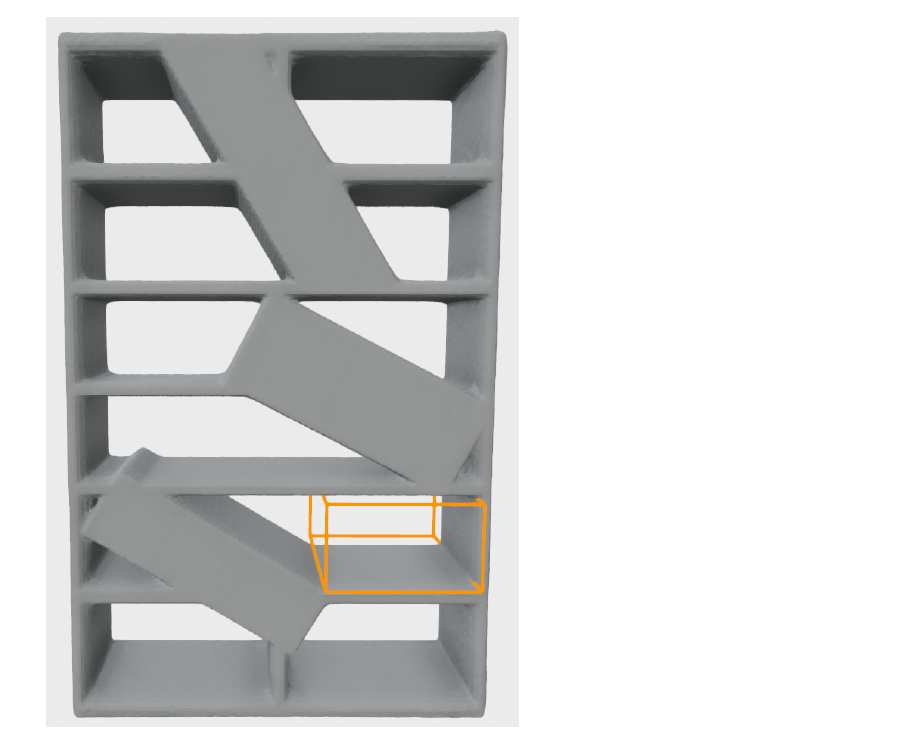
Figure 5. Selected mesh furniture model with detected storage volume in mesh space. The storage volume is depicted with an orange bounding